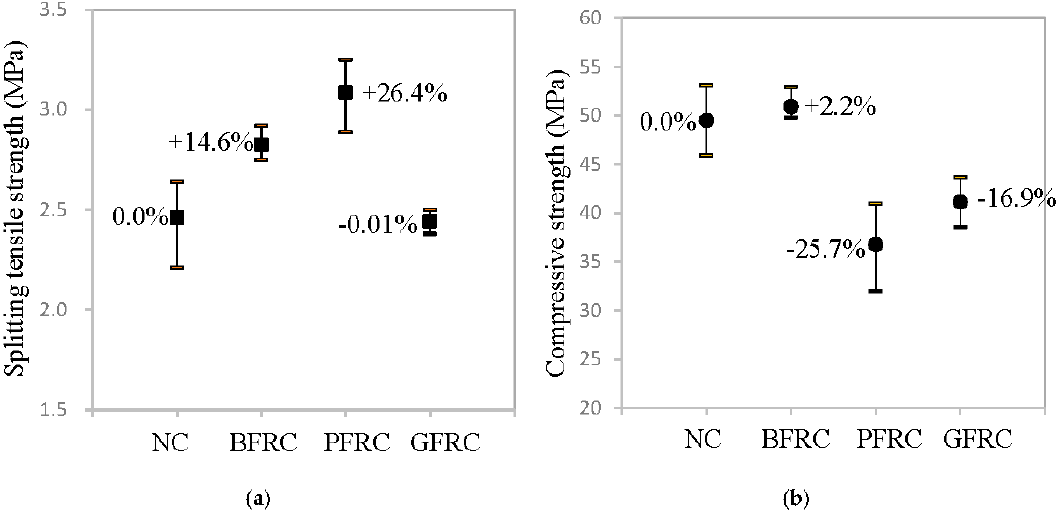
Figure 15. Test results of concrete specimens: ( a ) splitting tensile strength; and ( b ) compressive strength.